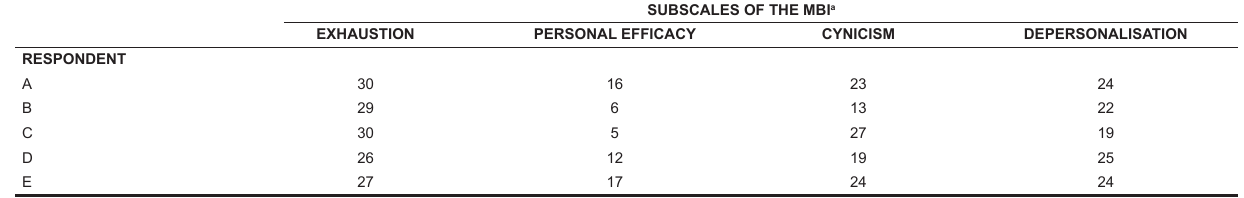
TABLE 4 MBI-GS scores for the five candidates with the highest test scores